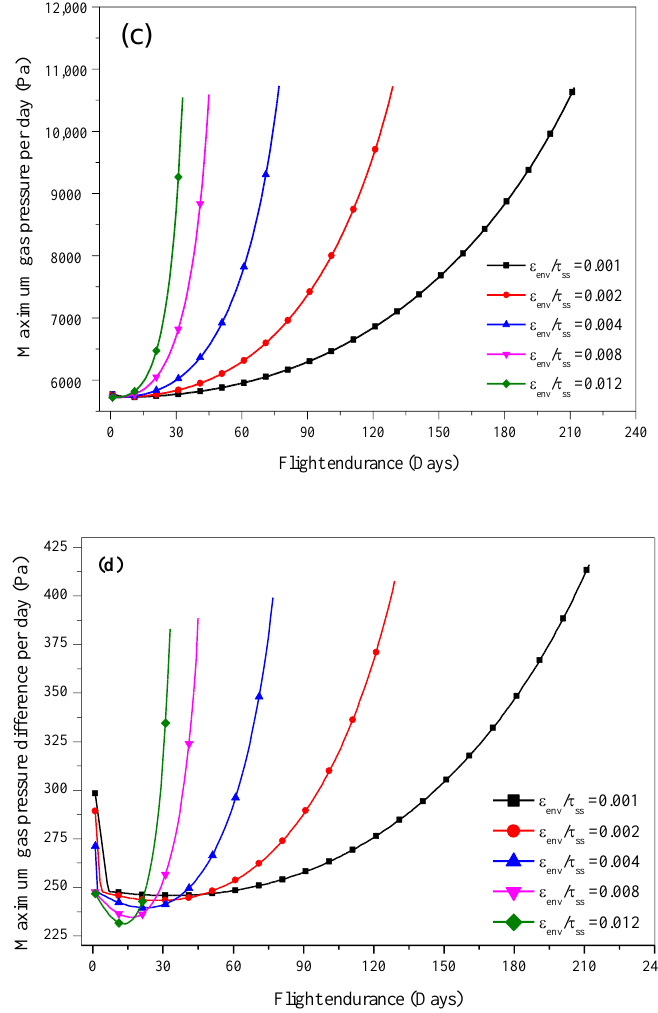
Figure 11. Effects of ε env / τ ss on the ( a ) maximum skin temperature per day, ( b ) maximum gas temperature per day, ( c ) maximum gas pressure per day, and ( d ) maximum gas pressure difference per day.